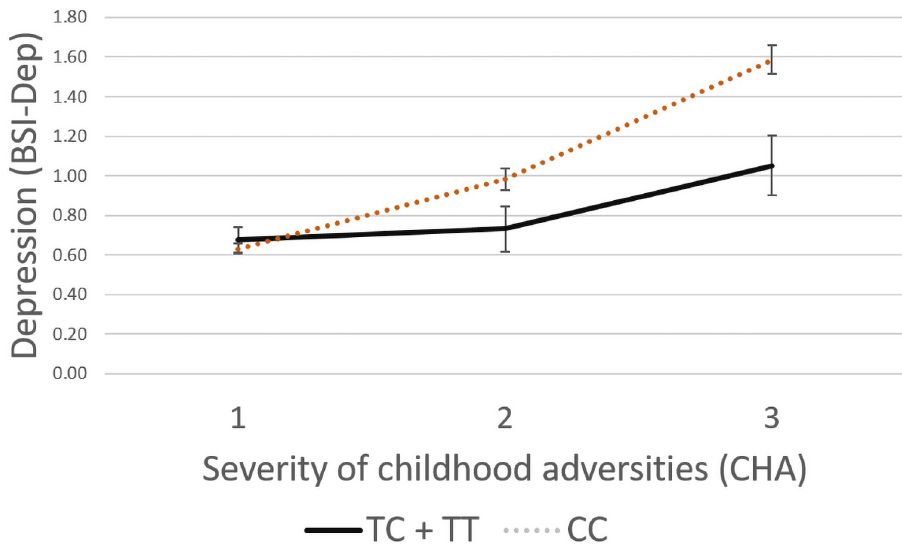
Fig 2. Linear regression analyses indicated a significant interaction between P2RX7 rs74892325 and exposure to childhood adversities on current depression, with the minor T allele as a protective allele. Linear regression indicated a significant interaction between P2RX7 rs74892325 genotype and severe childhood adversities (CHA) on current depression scores (BSI-DEP) according to the additive (p < 0.0001, FDR Q = 0.0006) and dominant (p < 0.0001, FDR Q = 0.0006) models. Presence of the minor T allele was associated with lower depression scores in subjects exposed to severe recent life events conveying a protective effect. On the vertical axis weighted depression (BSI-Dep) scores are shown. The horizontal axis shows severity of childhood adversities (CHA) categorised as 1: low = 0–3, 2: medium = 4–6, 3: high = 7 or more. While regression models were used in the analyses, the figure depicts results from ANOVA solely for visualisation purposes. Mean and SEM values are